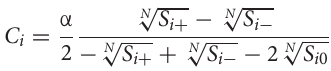
Frontiers in Neuroscience |